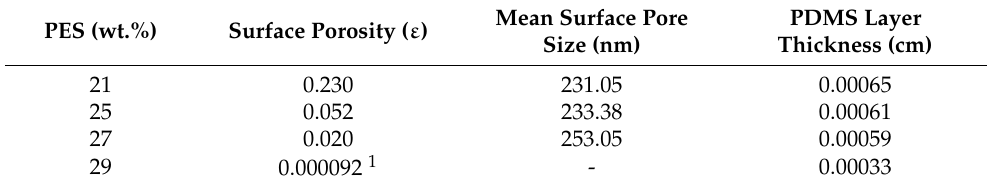
Table 1. Characteristics of PES substrate and PDMS layer thickness of PDMS/PES membrane.